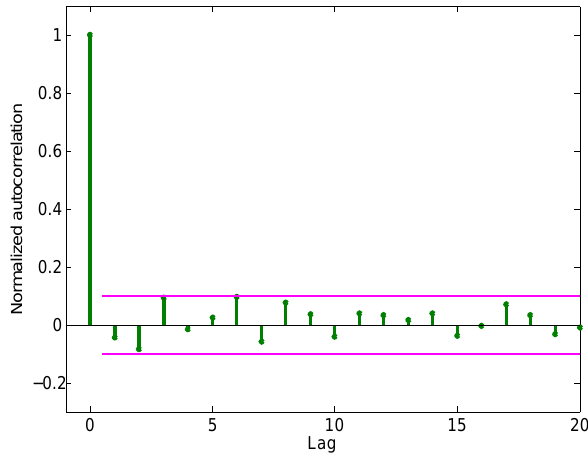
Figure 4. Normalized autocorrelation of the noise in measured